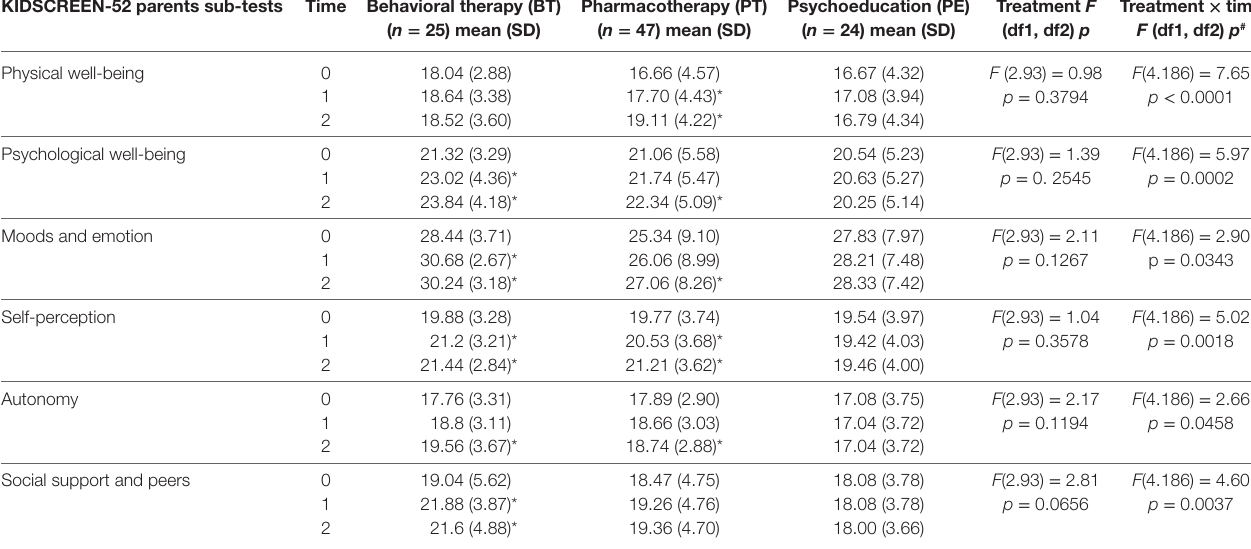
TaBle 5 | KIDSCREEN-52 (parents) outcome (values are expressed as absolute